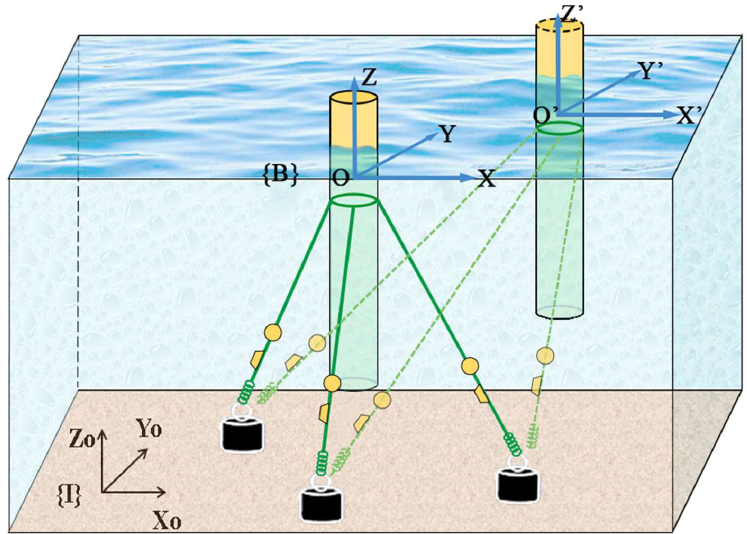
Figure 13. The in-plane and out-of-plane displacement of a foundation under waves.